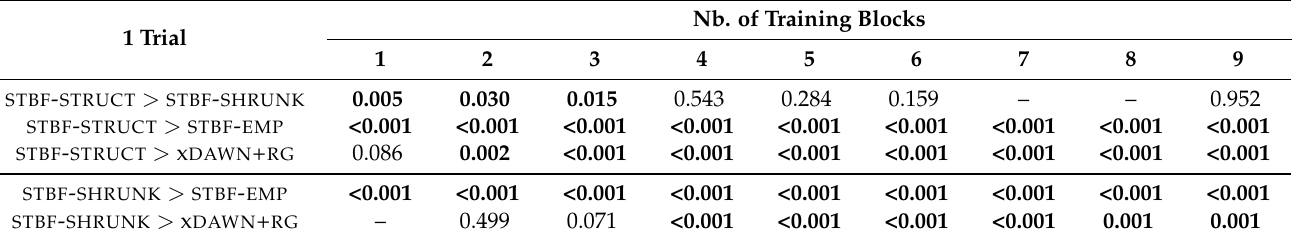
Table 1. p -values calculated via the one-sided paired Wilcoxon rank-sum test with Holm correction using one testing trial for different classifiers and levels of data availability. p -values < 0.05 are considered significant and marked